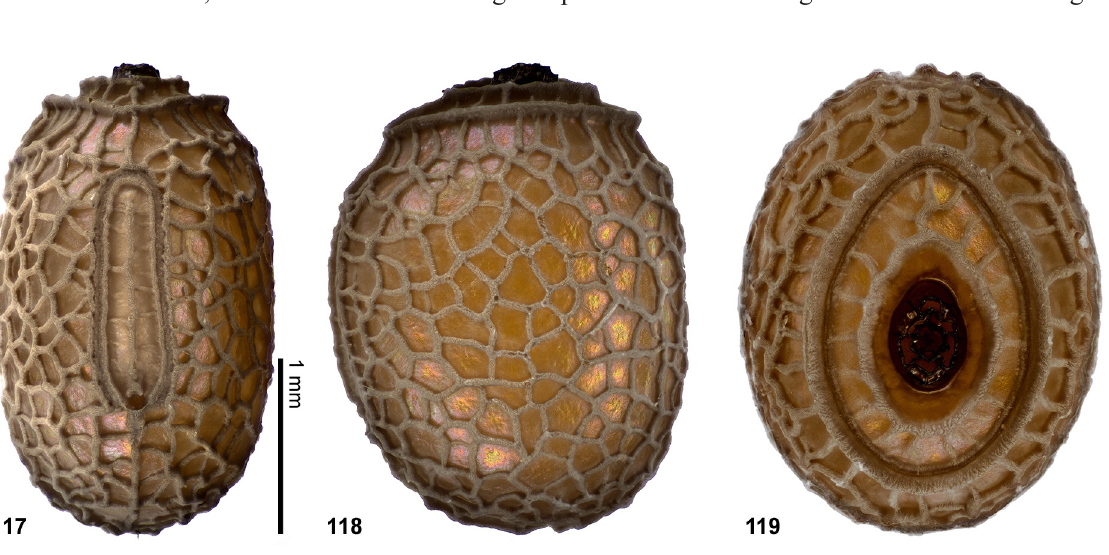
Figs 109–116 . Phantasca ruboligata sp. nov. Paratypes, ♂♂. 109 . Habitus, dorsal view. 110 . Habitus, lateral view. 111 . Head and pronotum, dorsal view. 112 . Head and pro- and mesothorax, lateral